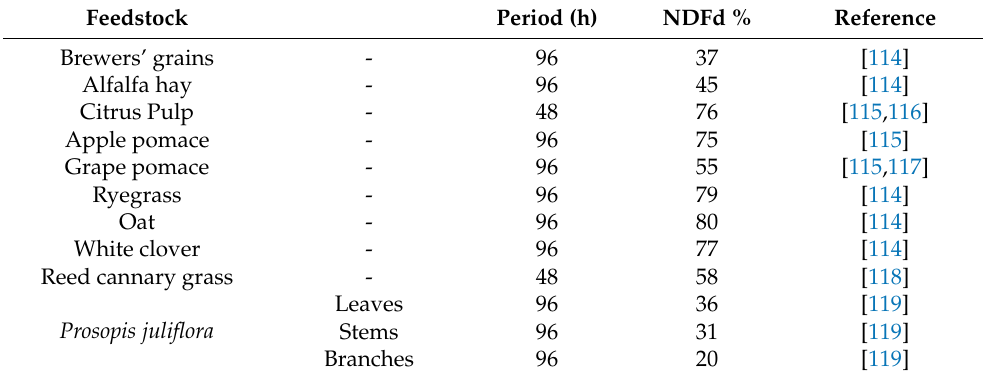
Table 5. In vitro digestibility of various wastes by the rumen microbes. Wastes detailed have only undergone mechanical pretreatment by milling and without additional